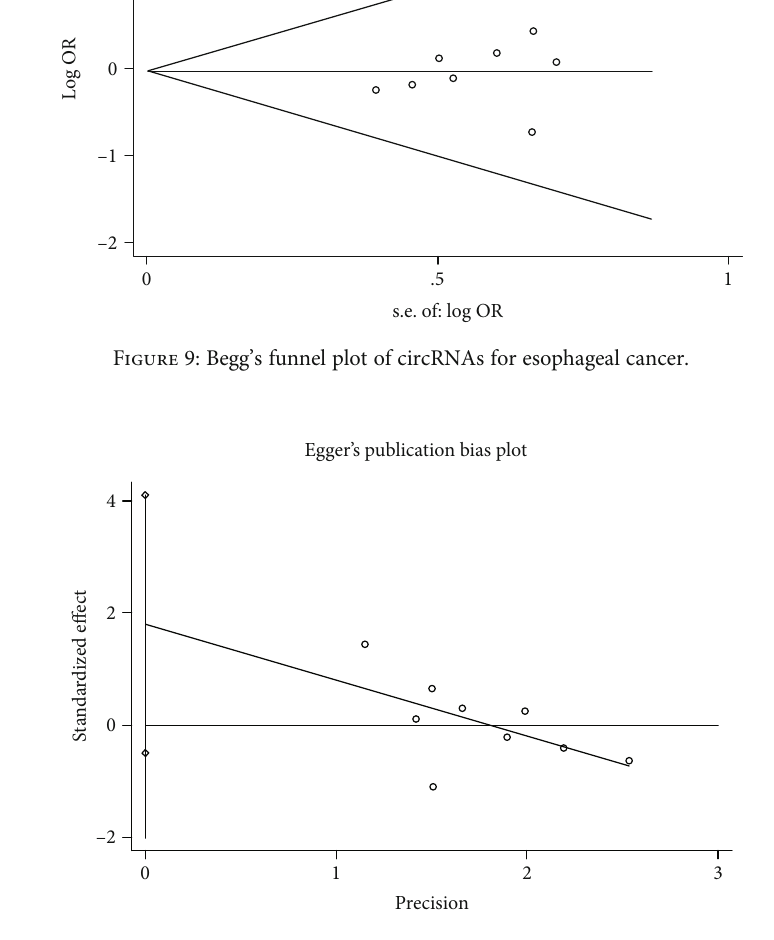
Figure 10: Egger ’ s funnel plot of circRNAs for esophageal cancer.